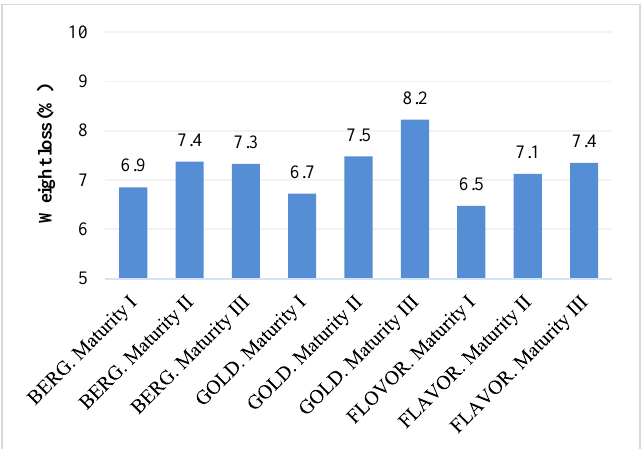
Figure 1. Effect of different harvest times (maturity classes) on the weight loss percentage of Bergarouge, Gold Cot and Flavor Cot apricot.